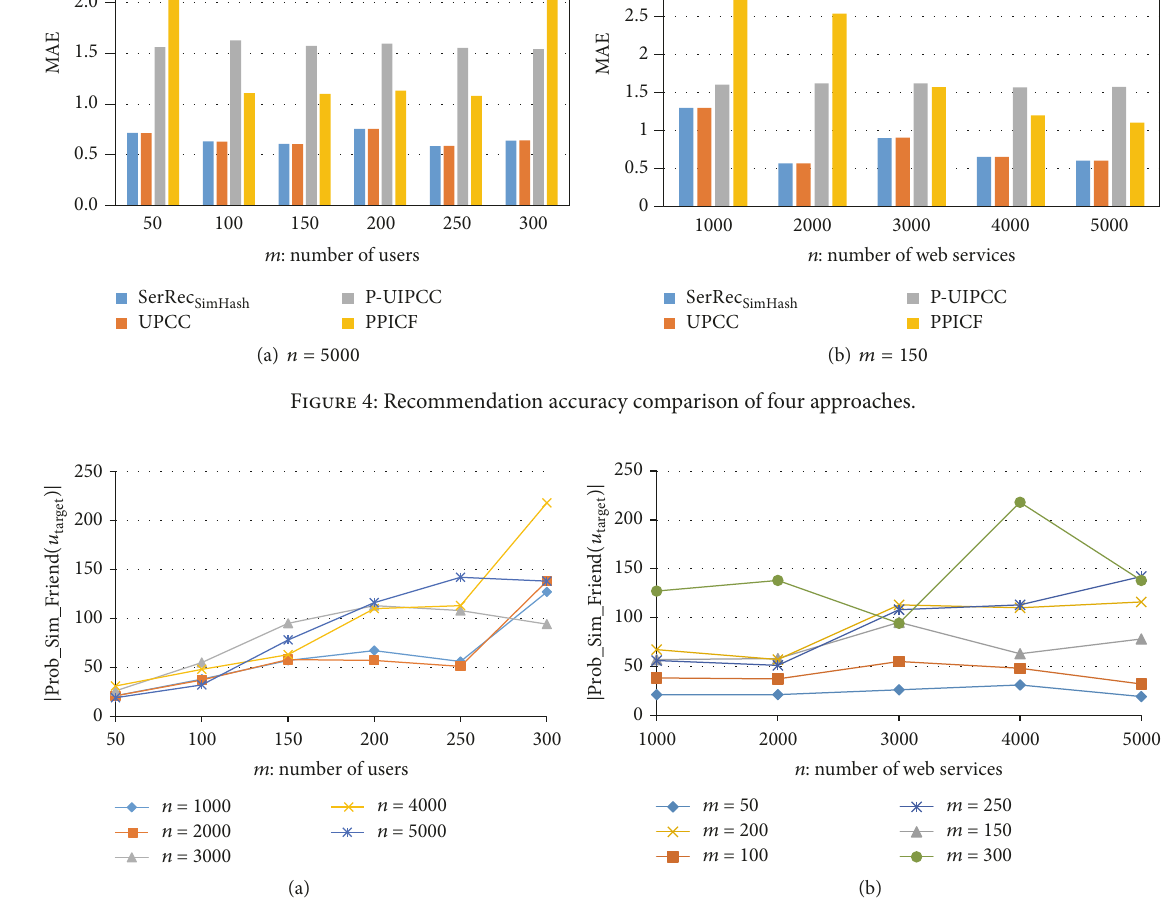
Figure 5: | Prob Sim Friend (𝑢